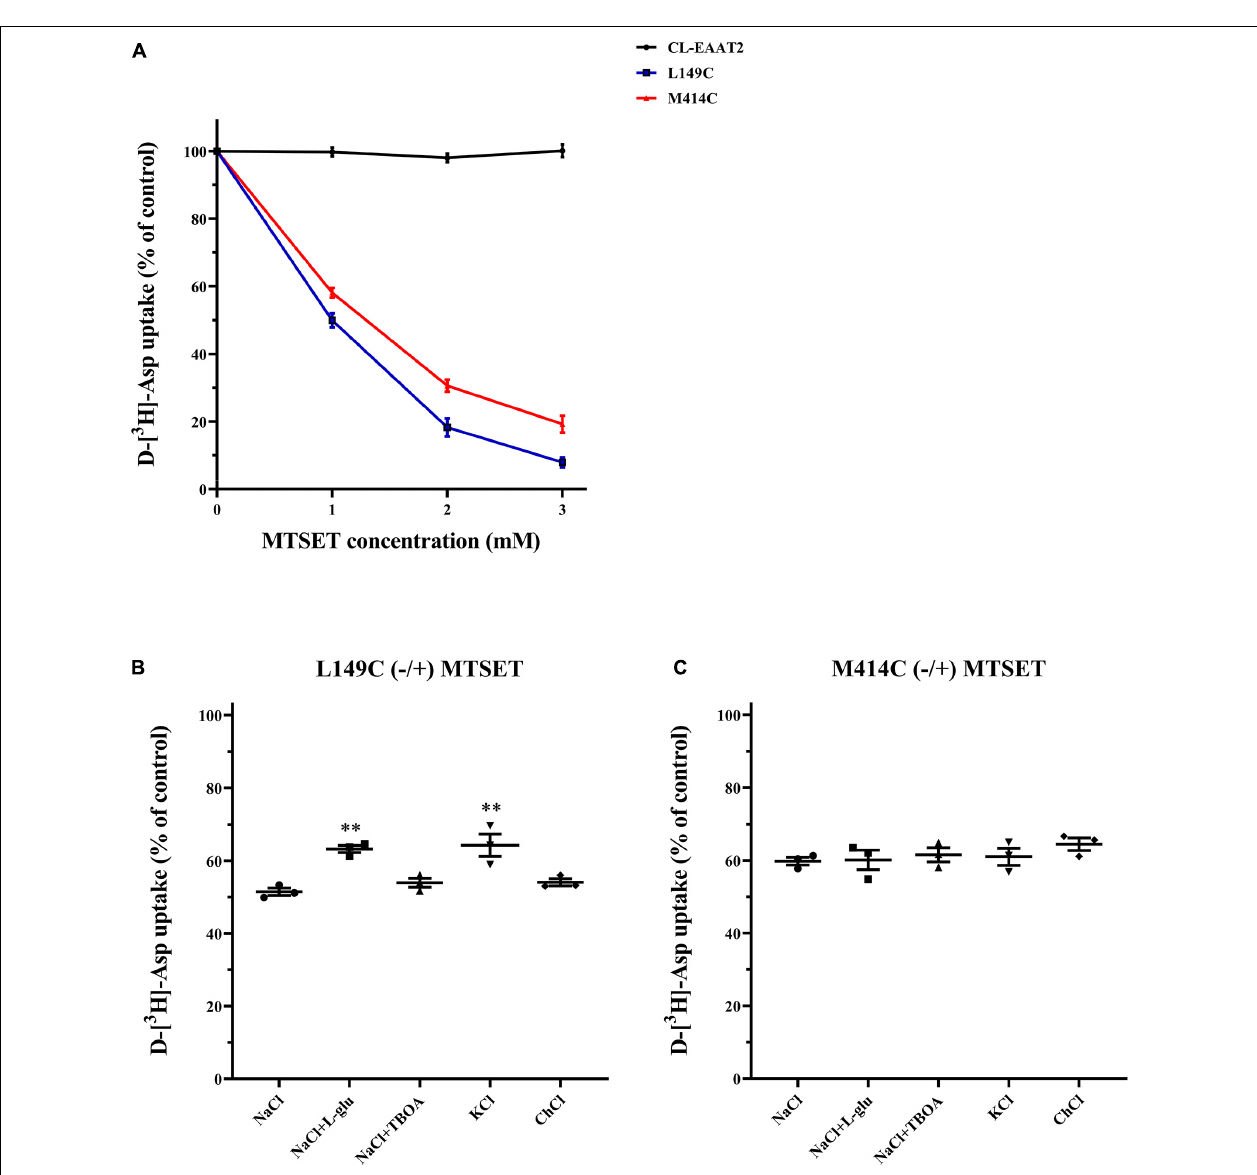
FIGURE 5 | Effects of outside medium on MTSET-induced inhibition in single mutants L149C and M414C. (A) D-[ 3 H]-aspartate uptake was determined in CL-EAAT2, L149C and M414C pre-incubated in incremental concentrations of MTSET. HeLa cells expressing L149C (B) and M414C (C) were treated with 1 mM MTSET mixed with different mediums (150 mM NaCl solution, NaCl solution + 1 mM L-glutamate, NaCl solution + 20 µ M TBOA, 150 mM KCl solution, and 150 mM choline chloride solution). Transport activity of L149C or M414C was normalized to that of two single mutants treated in corresponding medium without MTSET. Data are the means ± S.E. and representative of at least three separate experiments. Values significantly different from L149C or M414C treated with 1 mM MTSET in NaCl solution were determined by one-way ANOVA ( ∗∗ p < 0.01; n =